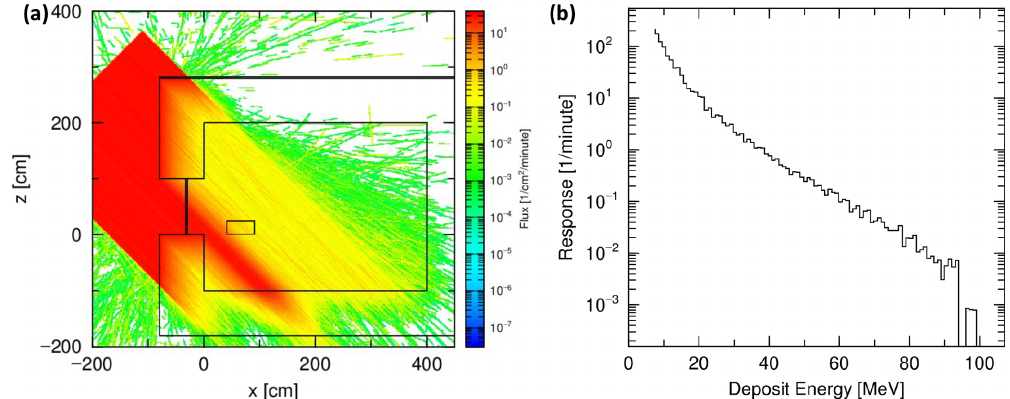
Figure 5. (a) TGE source particles. The source is tilted by 45 ◦ from the vertical axis, and the energy spectra correspond to observations by Chilingarian et al. (2012; their Fig. 12). (b) Calculated deposit energy spectra inside the scintillator. An energy threshold was set to 6.5MeV according to the set-up of the detector. The detector itself does not provide the energy